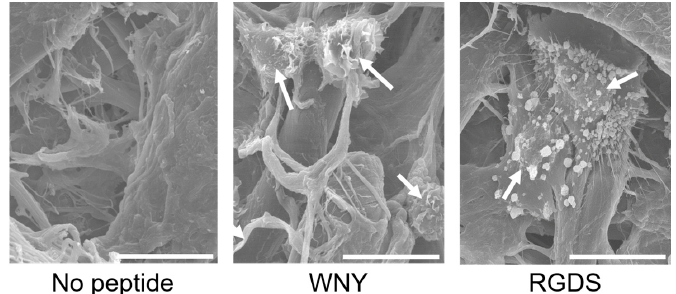
Figure 5. Scanning electron micrograph images of endothelial cells (ECs) on a Col IV-selective adhesion peptide (WNY)-coated and RGDS peptide-coated cellulose disk after 1 h of incubation. Adhered cells remaining after the washing procedure are indicated with white arrows. Scale bar, 15 μ m.